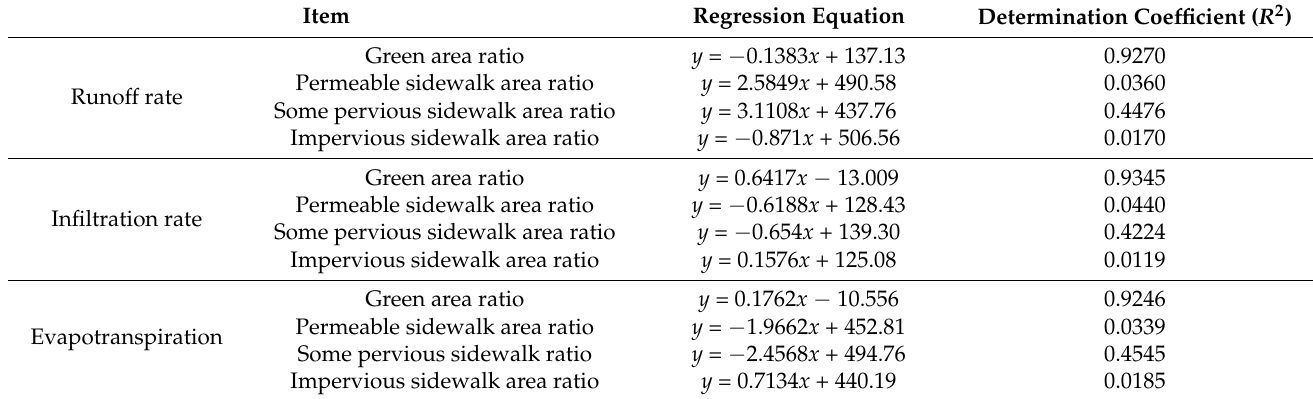
Table 8. Statistical analysis of the sidewalk forms influencing the water balance of urban